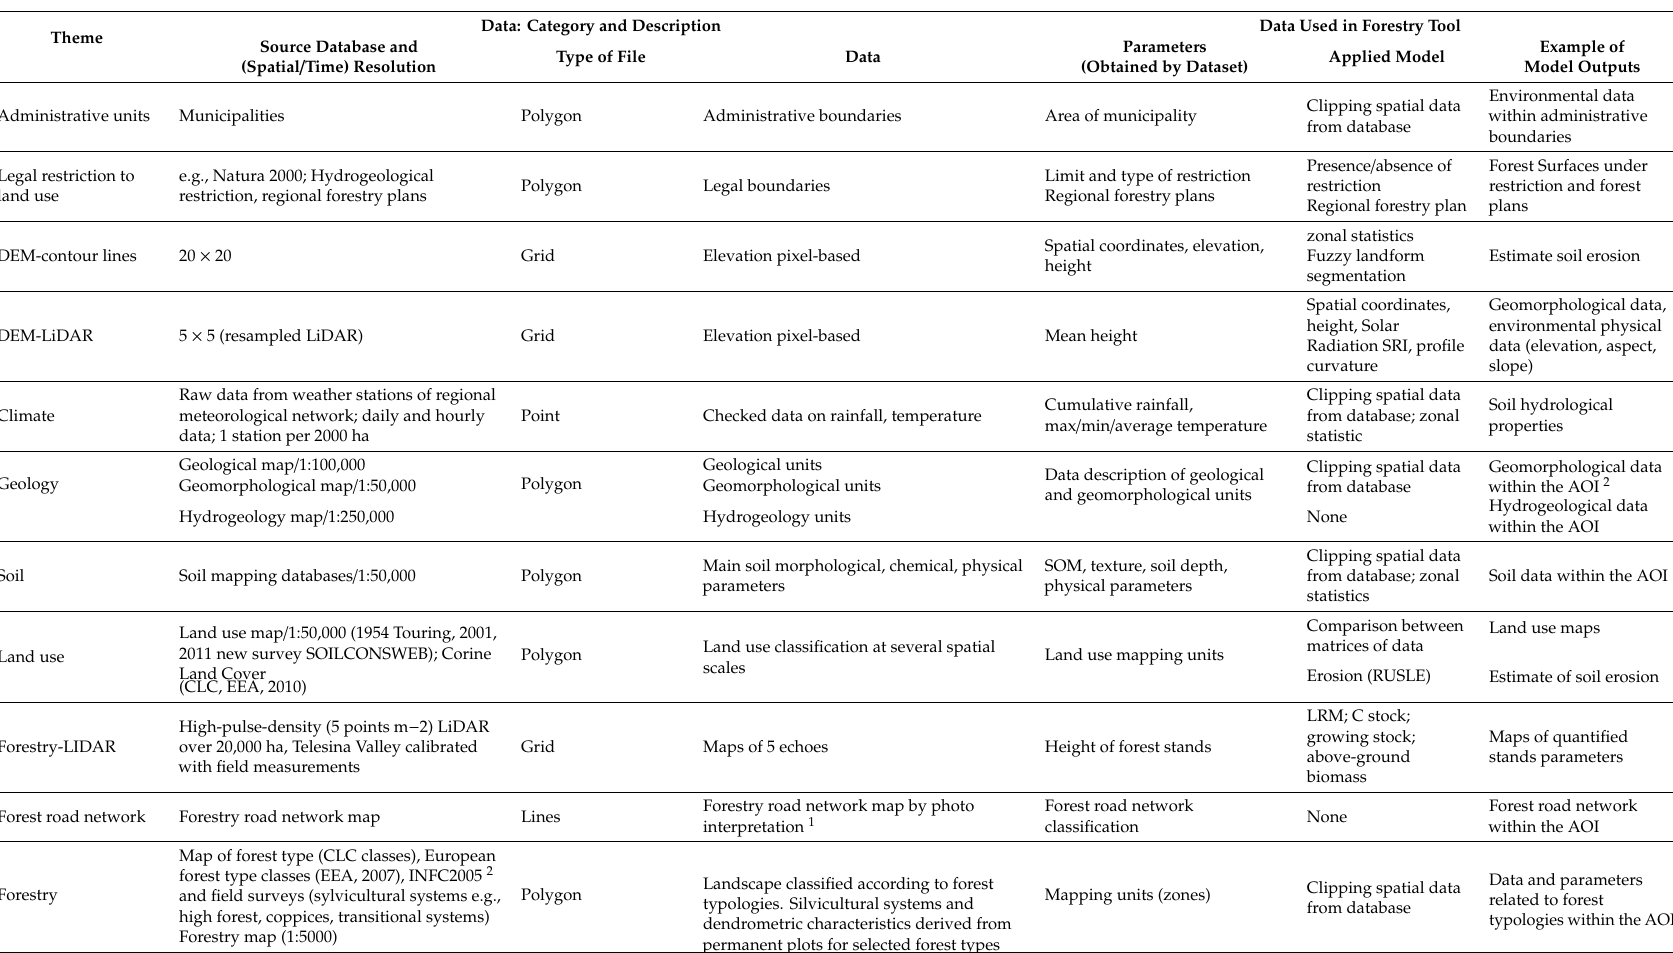
Table 1. Main databases employed in SOILCONSWEB-GCI for the forestry tool: description of data type and examples of their use / importance in